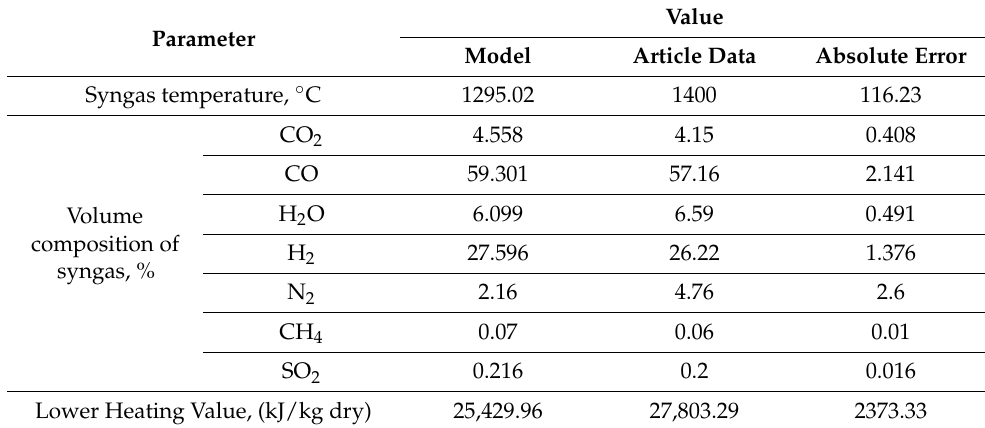
Table 5. Model calculation results, article data, and absolute